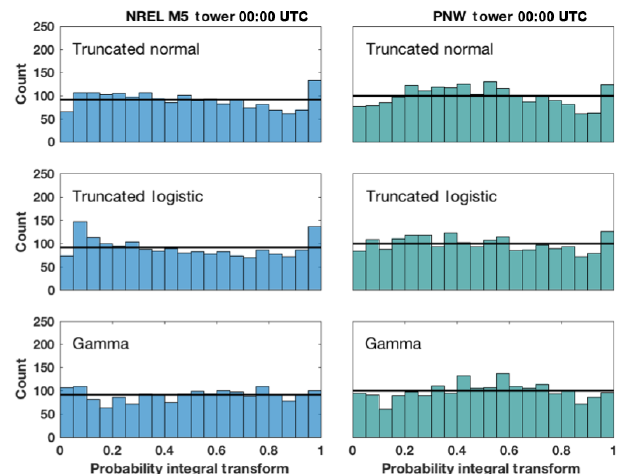
Figure 4. Histograms of the probability integral transform (PIT) using the predictive truncated normal, truncated logistic, or gamma distribution models at 00:00UTC for the M5 tower (blue) and PNW tower (green). The horizontal black line depicts the count that each of the 20 bins would have if the histogram was perfectly uniform.